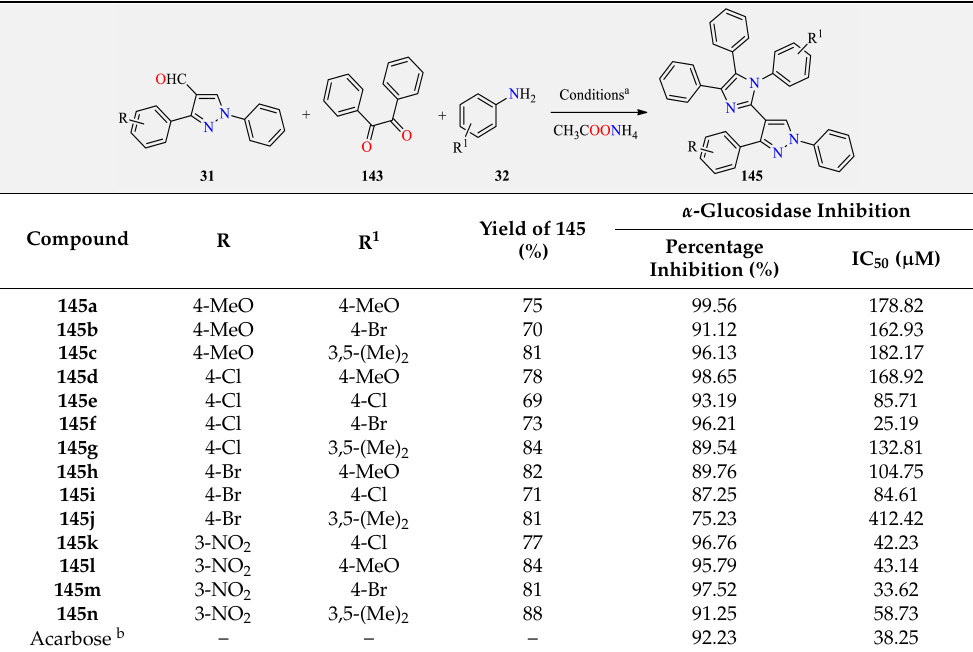
a Reaction conditions: Pyrazole-4-carbaldehydes 31 , benzil 143 , substituted anilines 32 , and ammonium acetate, AcOH, MWI. b Reference